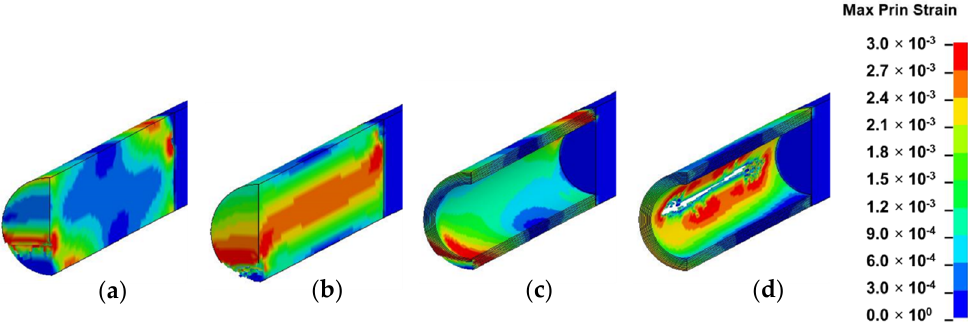
Figure 13. Fringe plots of maximum principal strain of: ( a ) solid-homogeneous; ( b ) solid-inhomogeneous; ( c ) hollow-homogeneous and ( d ) hollow-inhomogeneous models in shear mode.